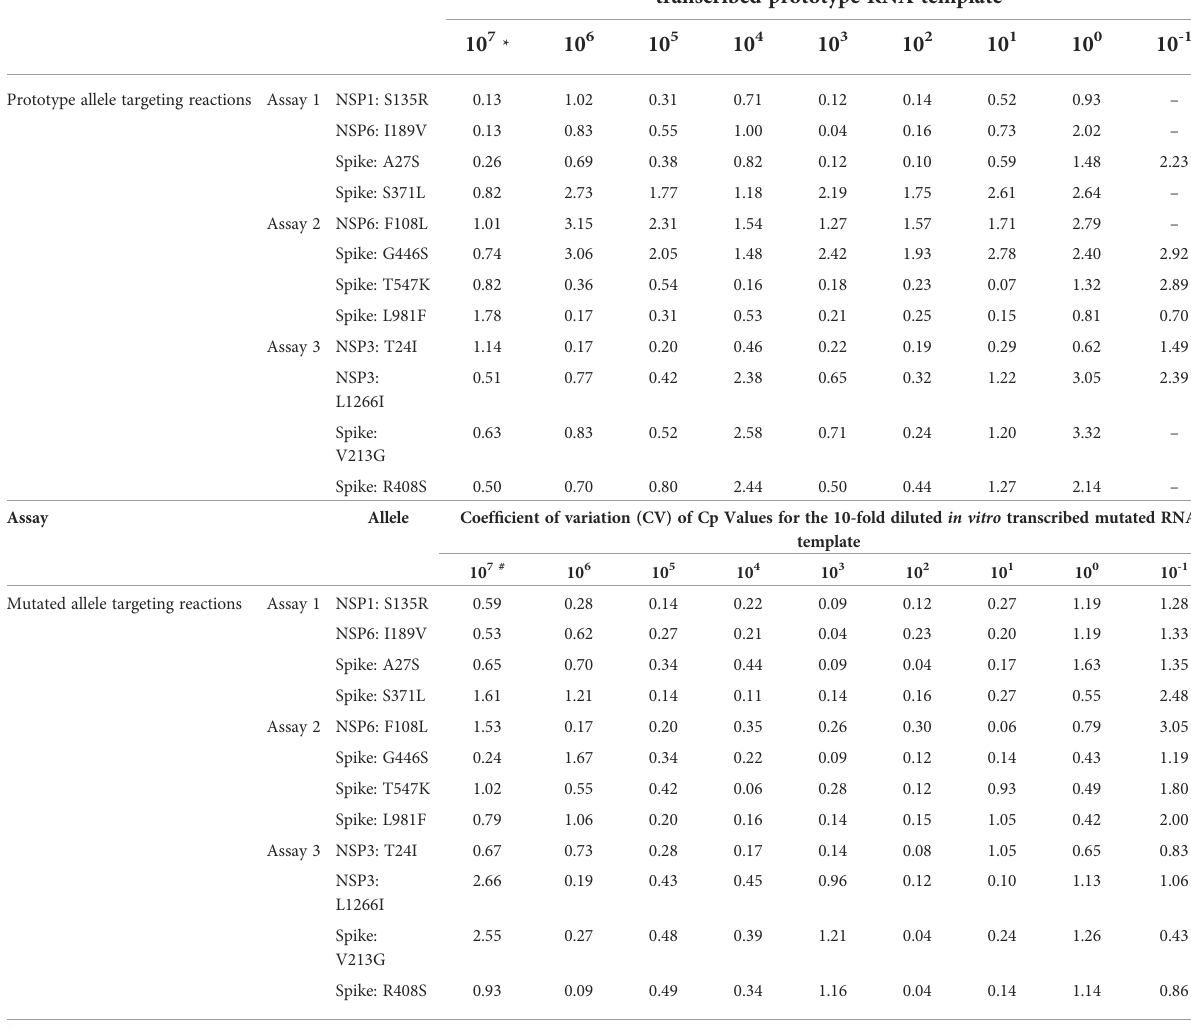
TABLE 3 Intra-assay reproducibility of the developed multiplex allele-speci fi c qRT-PCR assays. Assay Allele Coef fi cient of variation & (CV) of Cp Values for the 10-fold diluted in